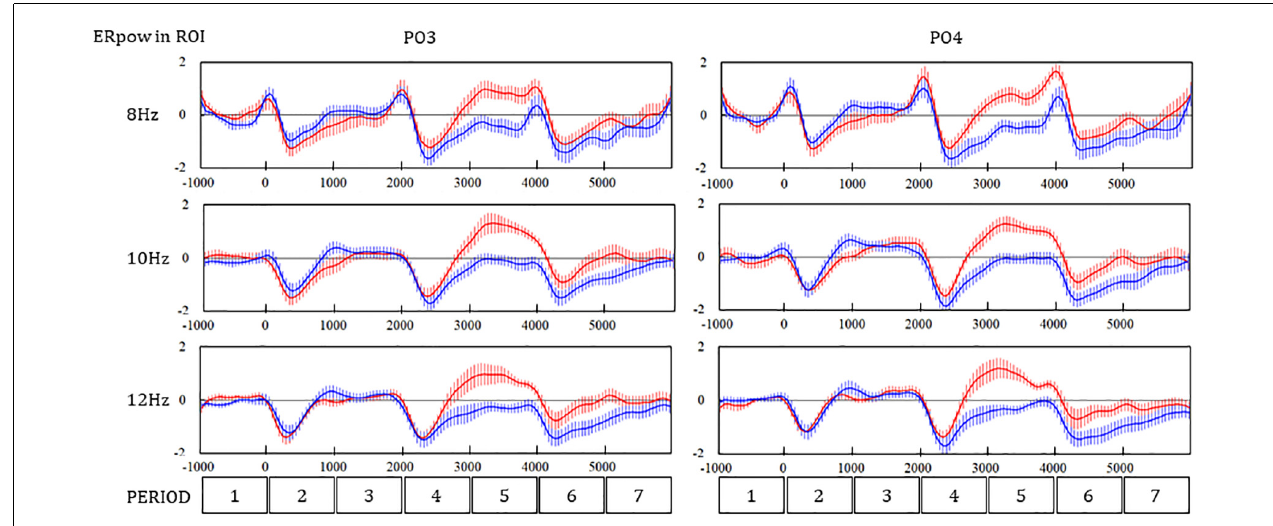
FIGURE 5 | Time series of ERpow at PO3 and PO4 during the SR and WM tasks. Redline, the self-reflection (SR) task; Navy line, the working memory (WM) task.